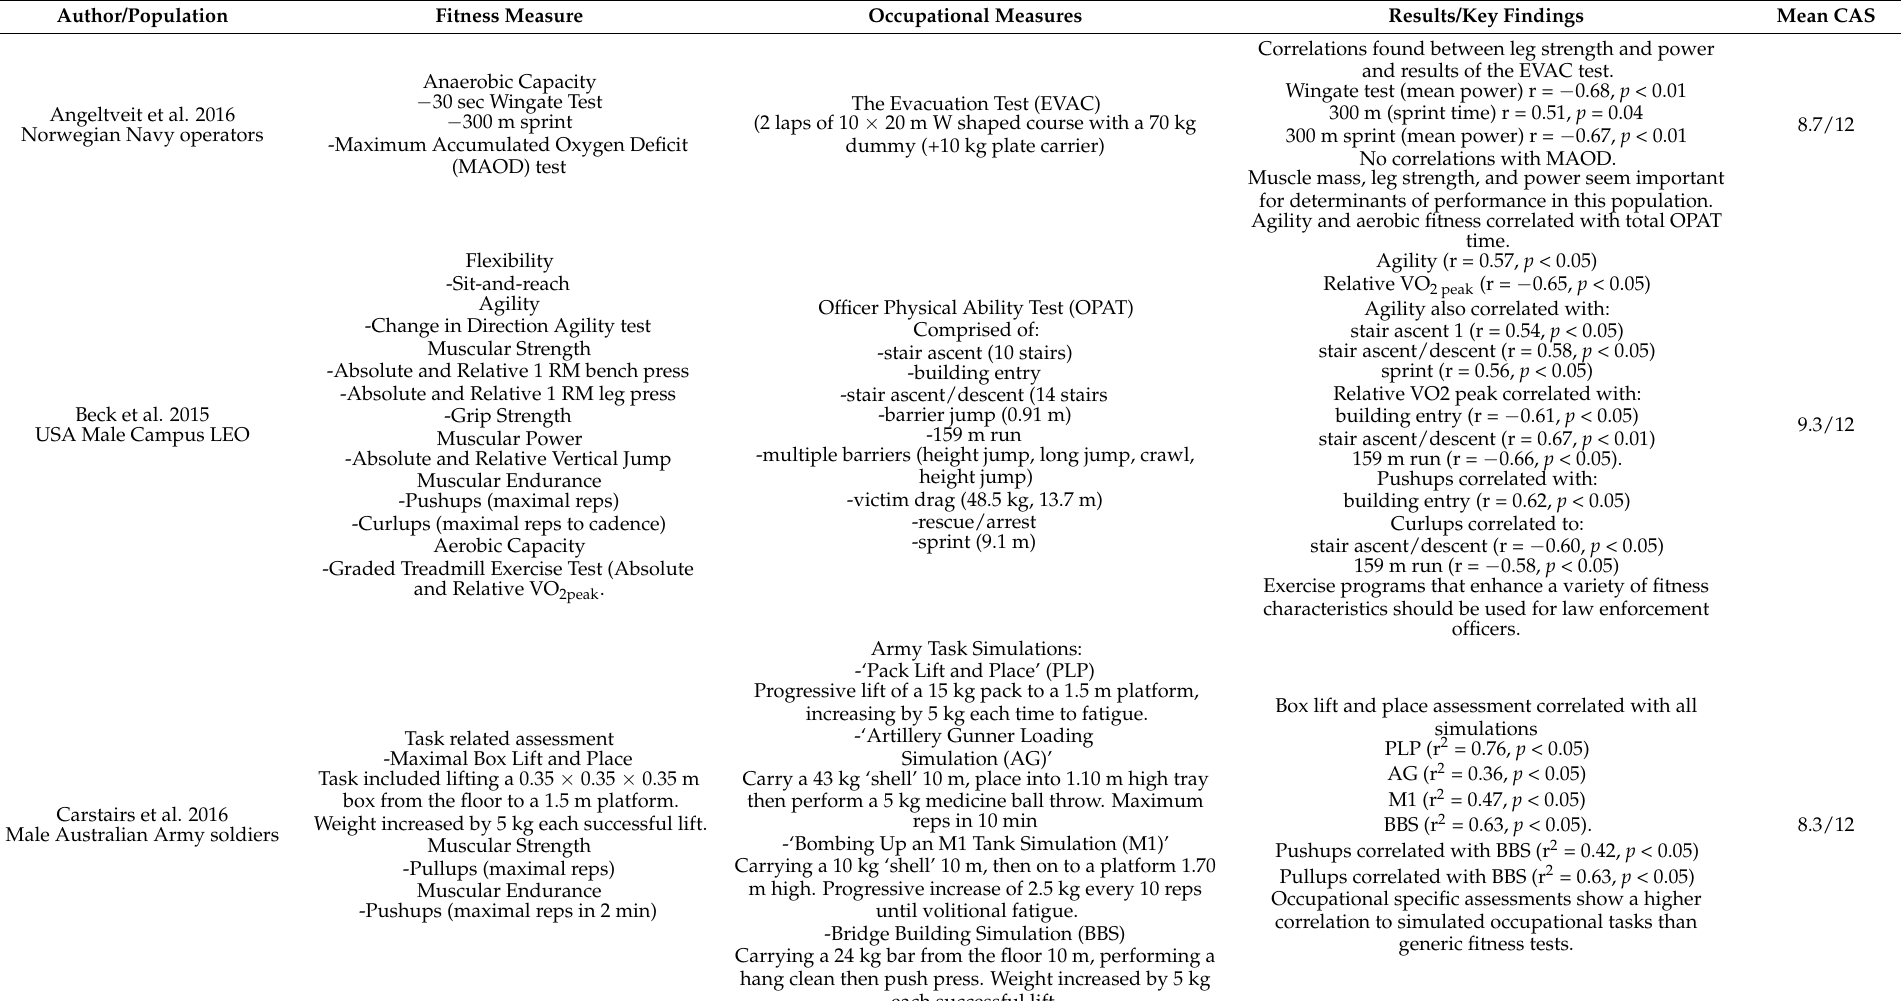
Table 3. Data extraction table including fitness and occupational performance measures with their key